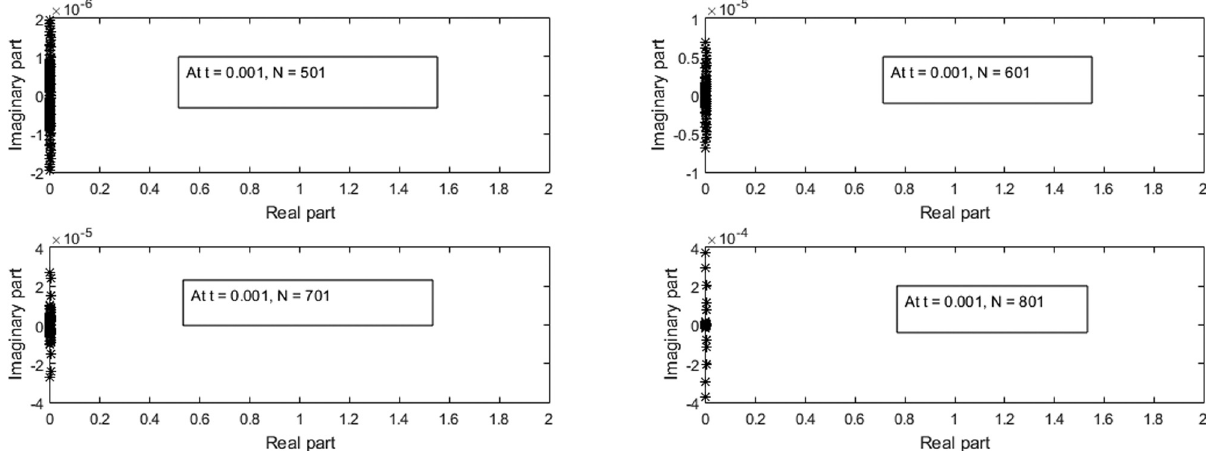
Figure 13: Stability of developed regime.